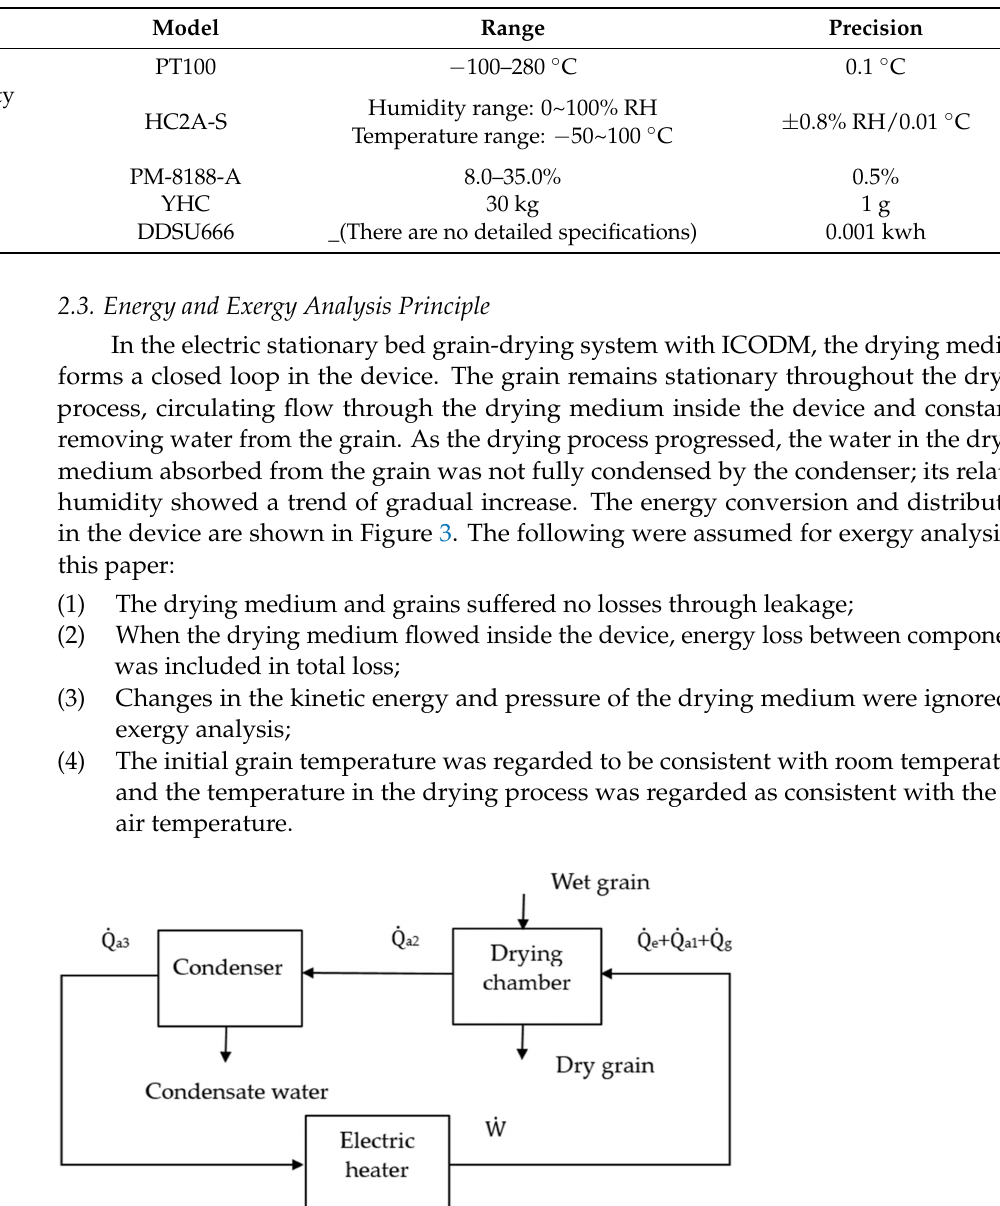
Table 3. Detection component model and parameter description.